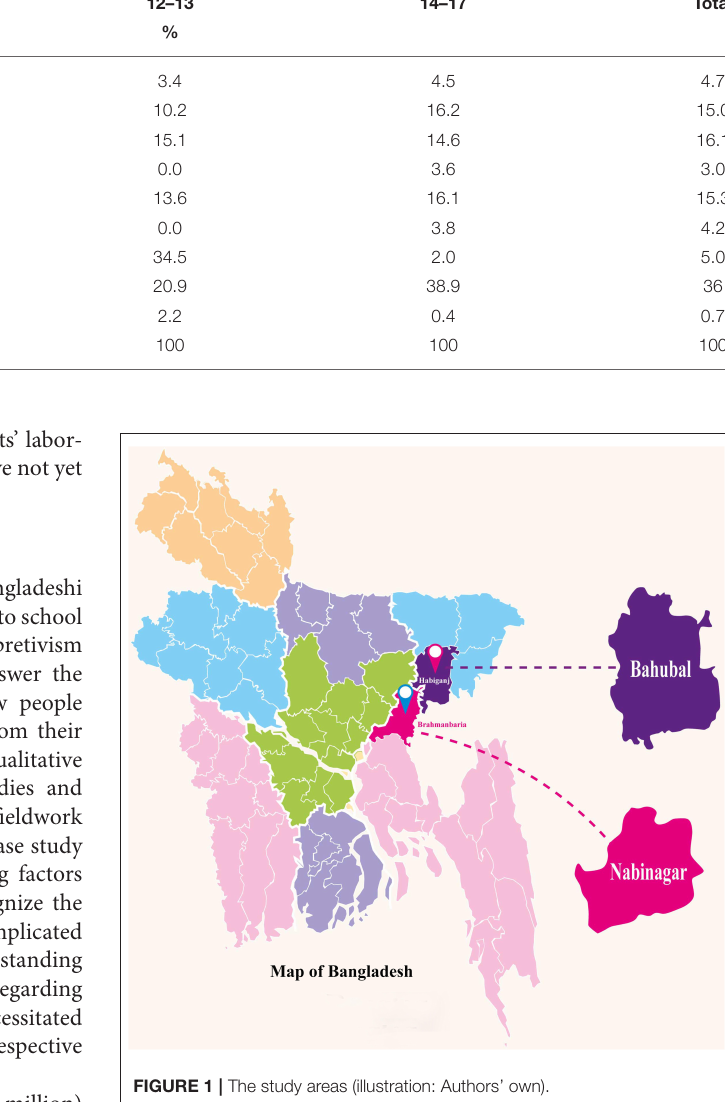
TABLE 1 | Distribution of child labor by the reasons of being dropped out, by age group in Bangladesh (Source: BBS, 2015, p. 80). Reasons